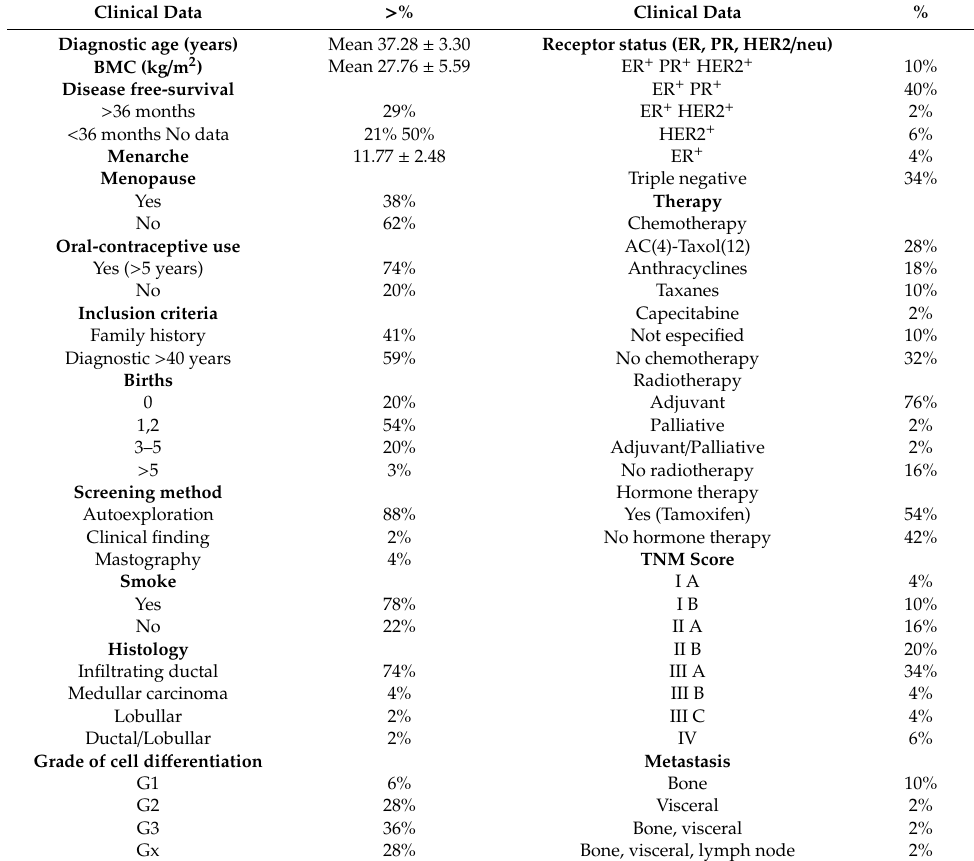
Table 2. Clinical description of the study population. Clinical aspects of hereditary breast and ovarian cancer (HBOC) participants.